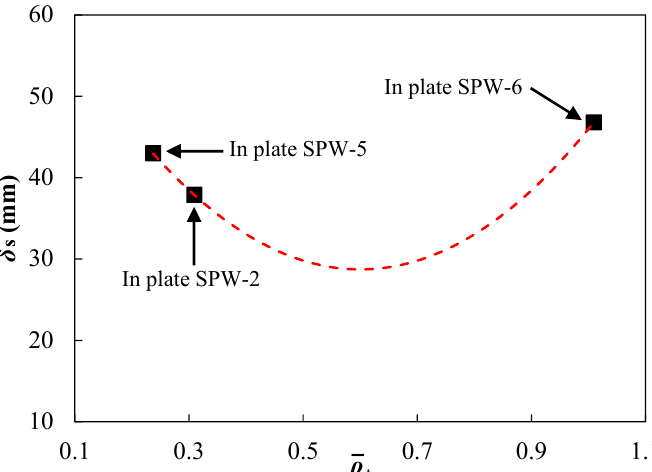
Figure 10. Influence of spraying thickness on the maximum permanent deflection ( δ s ) of the front steel layers in different polyurea ‐ coated steel plates at a stand ‐ off distance of 100 mm.